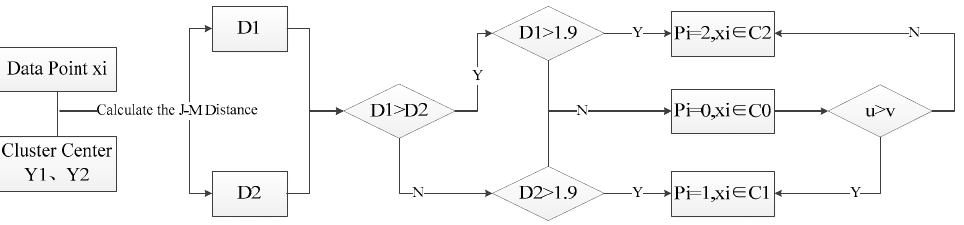
Figure 3. Workflow of the classification